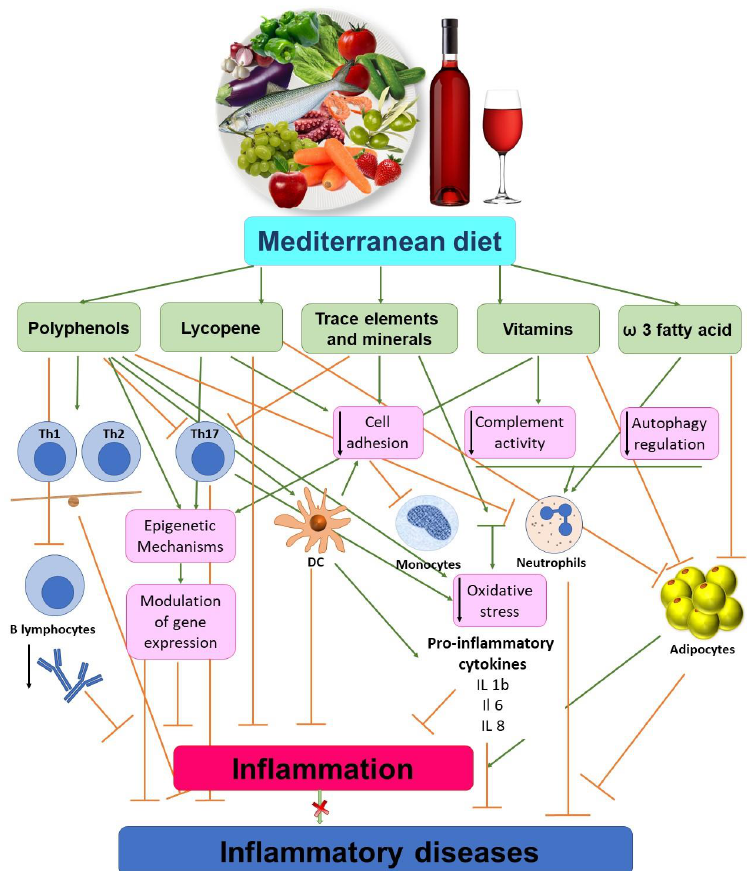
Figure 1 . The Mediterranean diet (MD) as anti-inflammatory properties. The MD is rich in antioxidants, trace elements, minerals and vitamins which have anti-inflammatory properties.